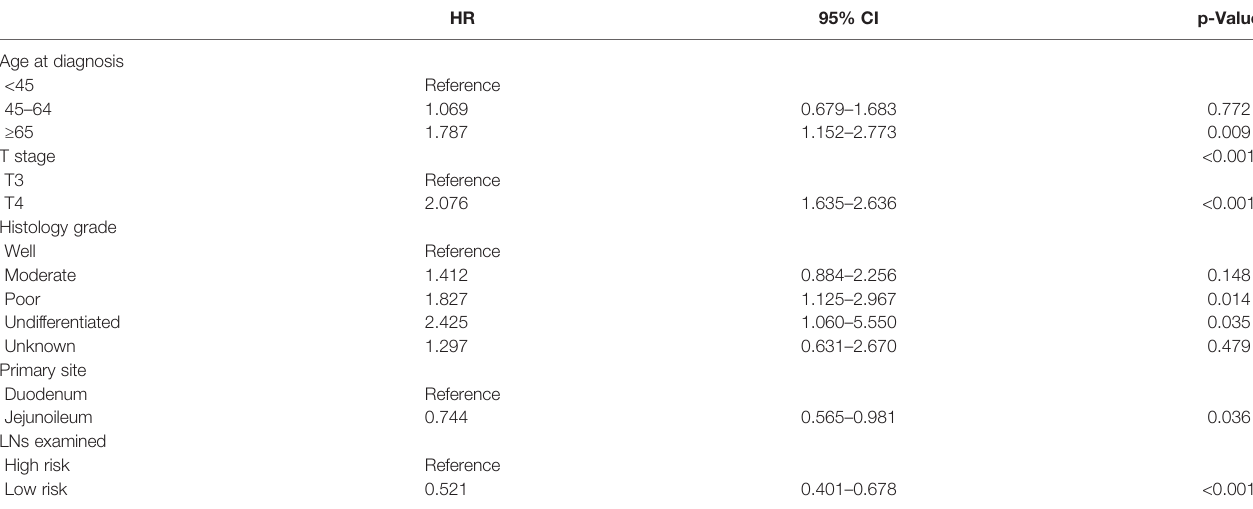
TABLE 3 | Multivariate Cox regression analyses of patients with small bowel carcinoma.